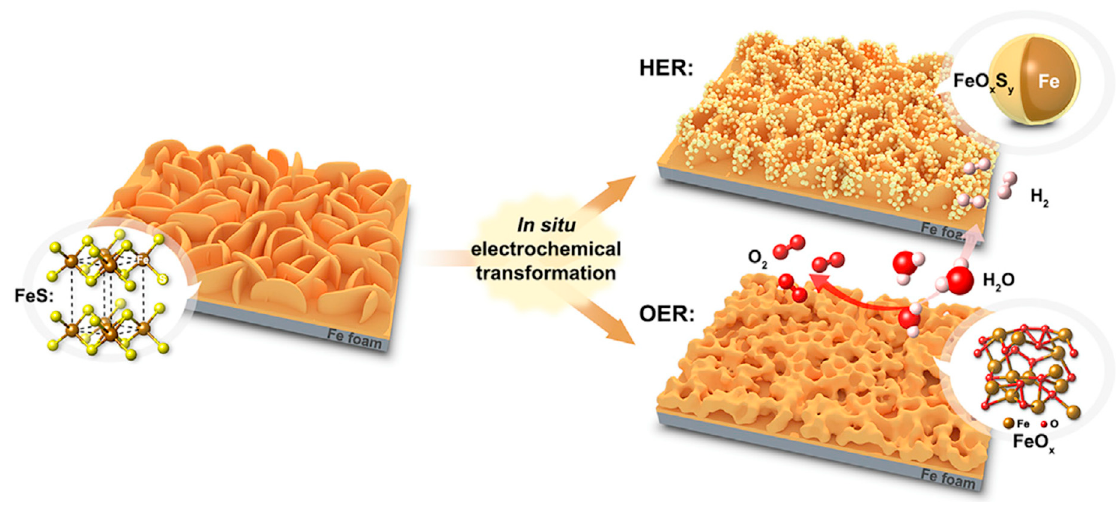
Figure 1. FeS nanosheets grown on iron foam act as pre-catalyst for generation of Fe@FeO x S y , which is a highly active electrocatalyst and splits water simultaneously into molecular hydrogen and oxygen. Reprinted with permission from reference [34].